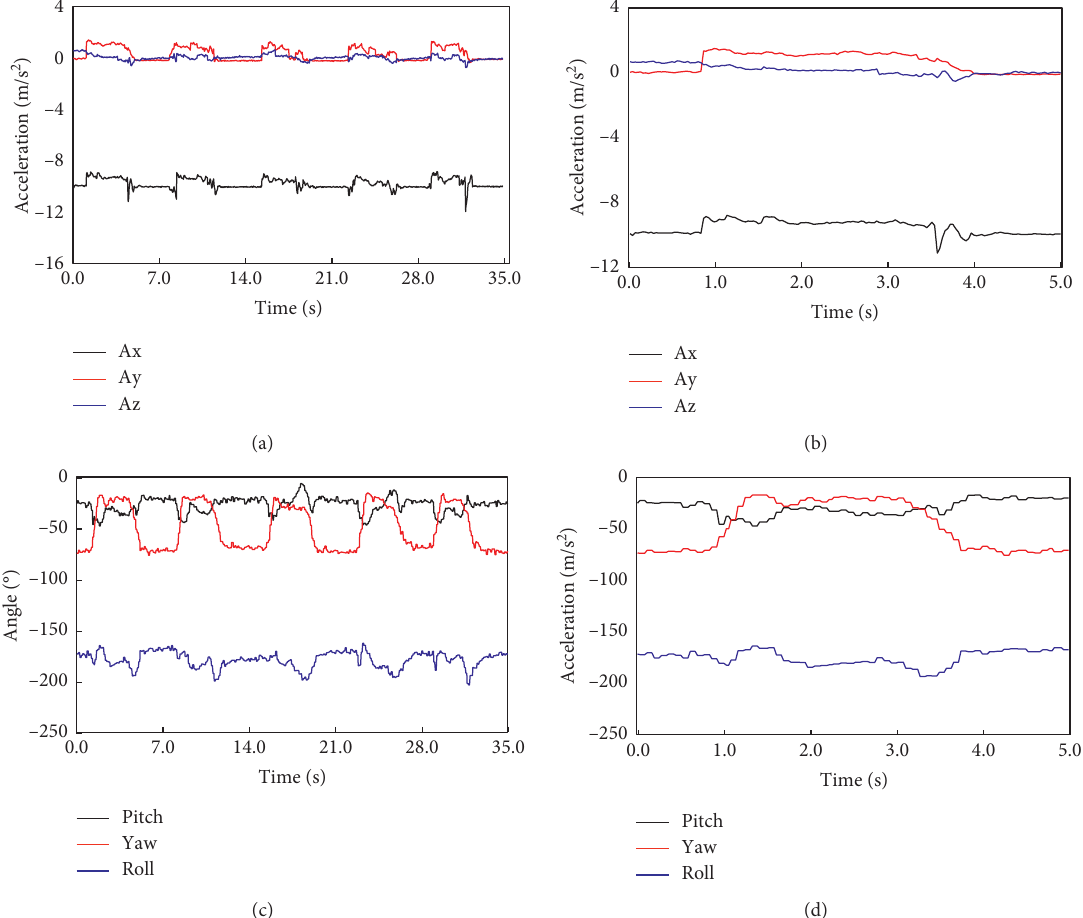
Figure 8: (a) Acceleration change curve of five leg lifts. (b) Acceleration change curve of single-leg lift. (c) Angle change curve of five leg lifts. (d) Angle change curve of single-leg lift.